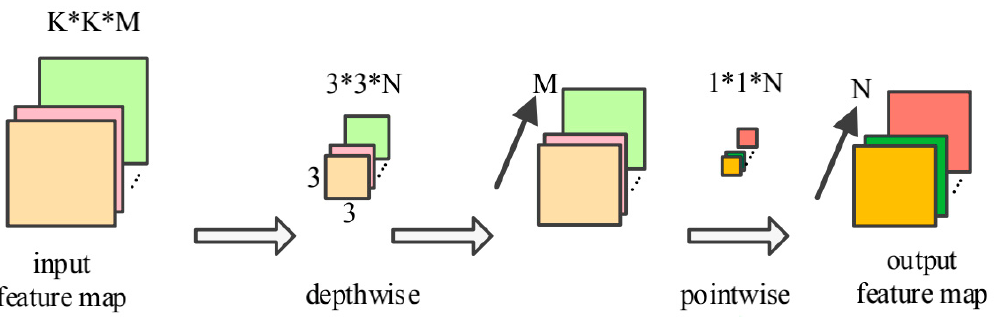
Figure 4. Depthwise separable convolution (DSC).